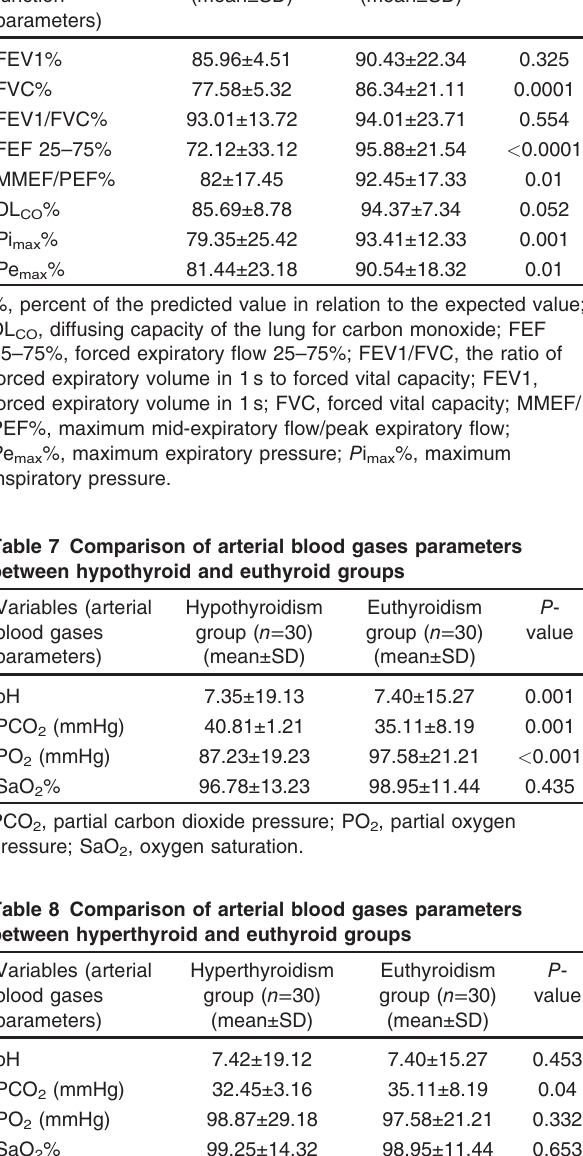
Table 6 Comparison of spirometric function parameters between hypothyroid and hyperthyroid groups Variables (spirometric